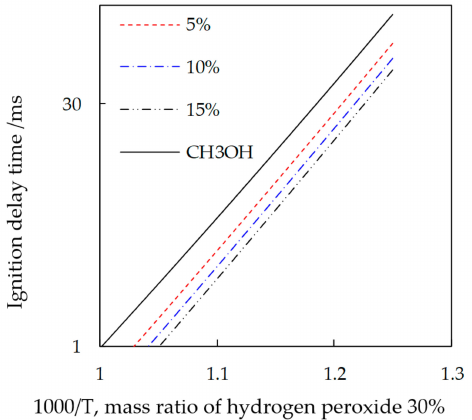
Figure 6. E ff ect of hydrogen peroxide on methanol